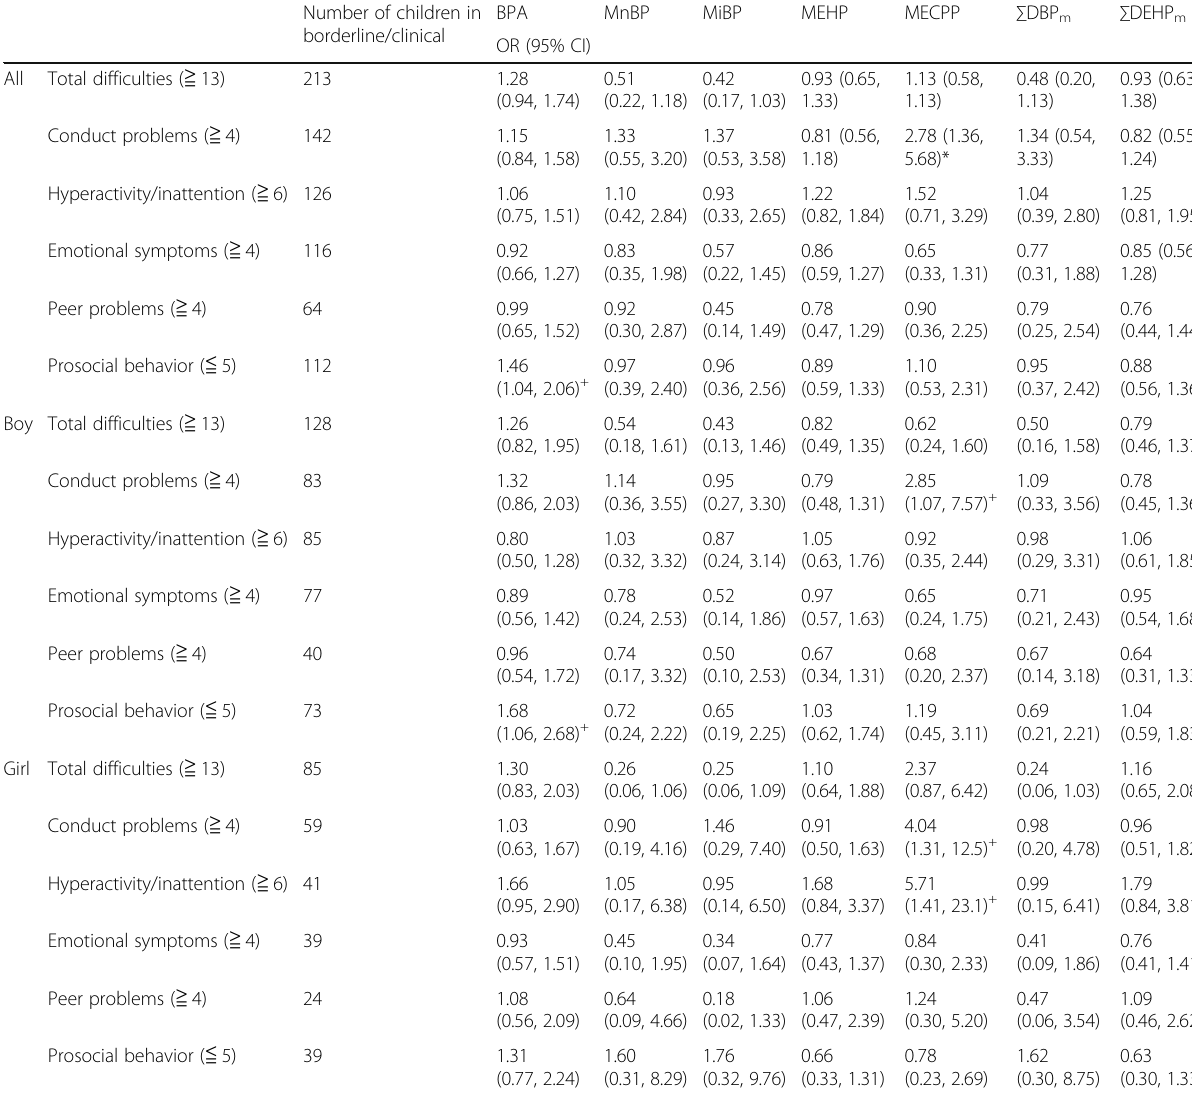
Table 3 Adjusted odds ratios for a tenfold increase of maternal BPA and phthalate metabolite levels on having behavioral problems Number of children in